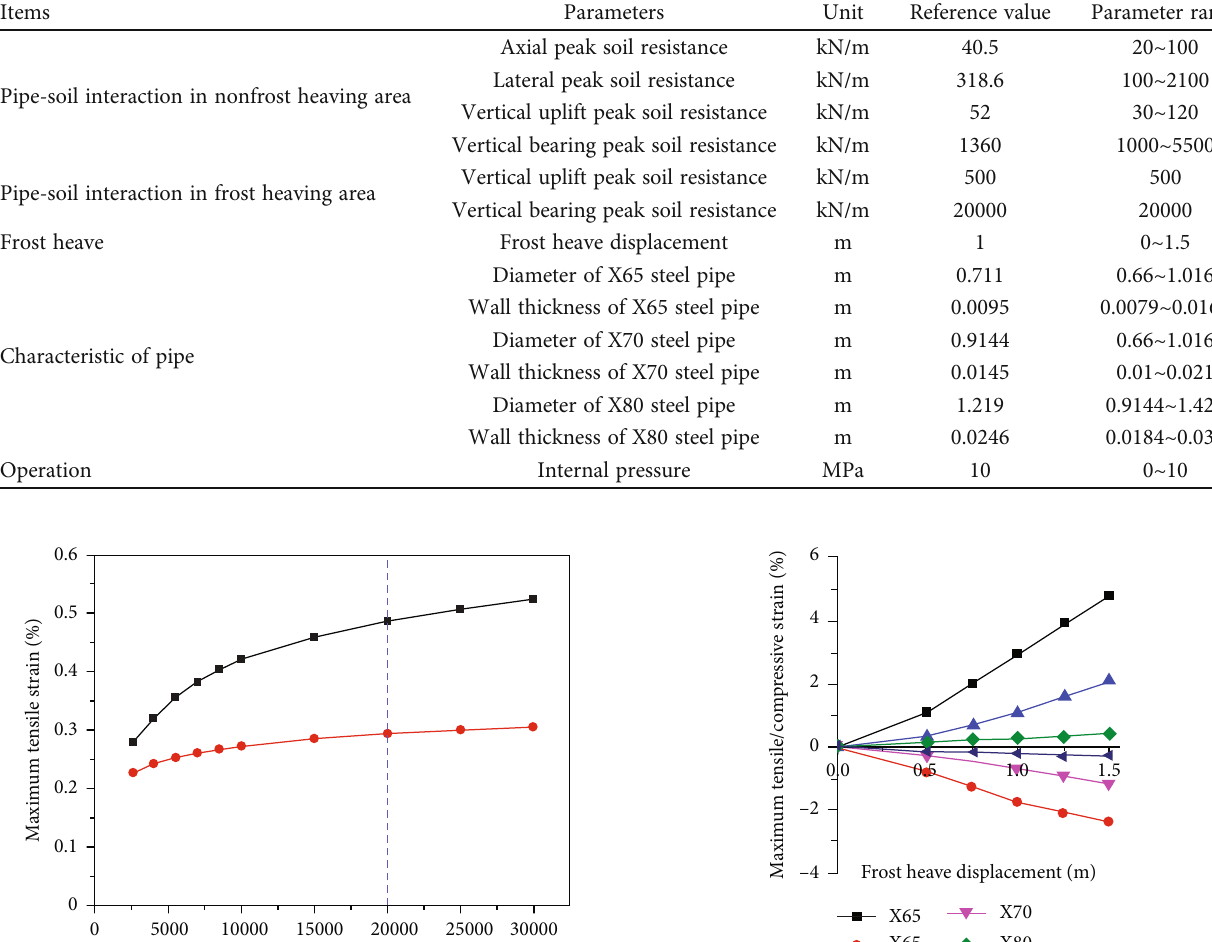
Table 1: Sensitivity parameter range of X65, X70, and X80 steel pipelines.